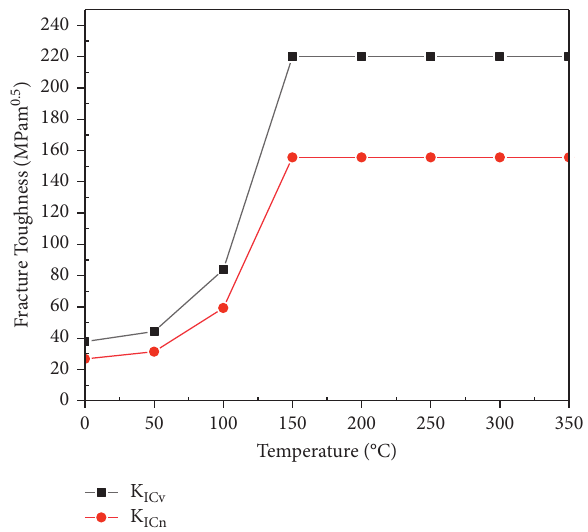
Figure 2: Fracture toughness curve of the irradiated referenced RPV steel.